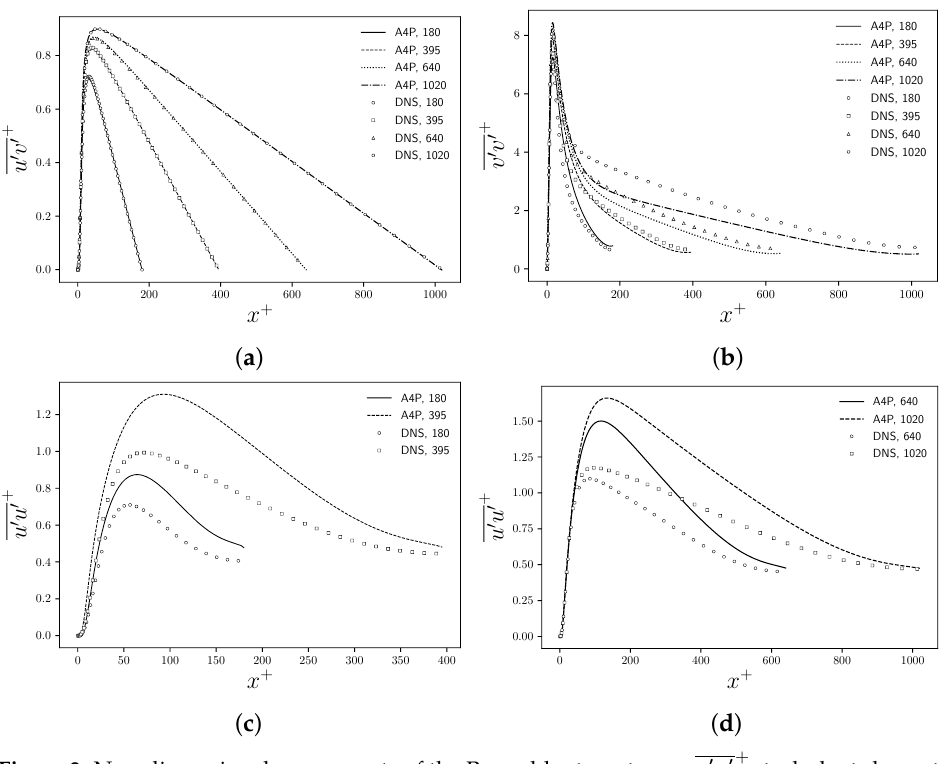
Figure 3. Non-dimensional components of the Reynolds stress tensor u (cid:48) + u (cid:48) v (cid:48) ( a ), streamwise normal stress v (cid:48) v (cid:48) Re τ = 180,395,640,1020. DNS data from